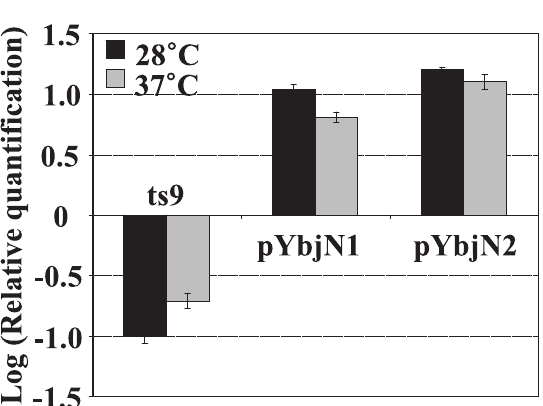
Figure 1. Expression level of ybjN is directly related to its ability to rescue the temperature sensitivity of Escherichia coli ts9 mutant. A. Over-expression of ybjN from both E. coli and Erwinia amylovora rescued the temperature sensitivity of ts9 mutant of E. coli . BW: E. coli strain BW25113; pYbjN1 and pYbjN2: E. coli and E. amylovora ybjN gene in pGEM T easy vector, respectively; Empty vector ( pGEM T easy ) as negative control. Columns represented two dilutions of inoculum at both temperatures. B. Relative expression of ybjN gene in the ts9 mutant and the ts9 mutant strain harboring high copy plasmids of ybjN gene from both E. coli and E. amylovora compared to the E. coli strain BW25113 by qRT-PCR, normalized to the expression value of 16S rRNA ( rrsA ) gene. Cells were grown in LB broth with shaking overnight at 28 u C and 6 h at 37 u C. ts9: E. coli ts9 mutant; pYbjN1: ts9 over- expressing E. coli ybjN gene; pYbjN2: ts9 overexpressing E. amylovora ybjN gene.